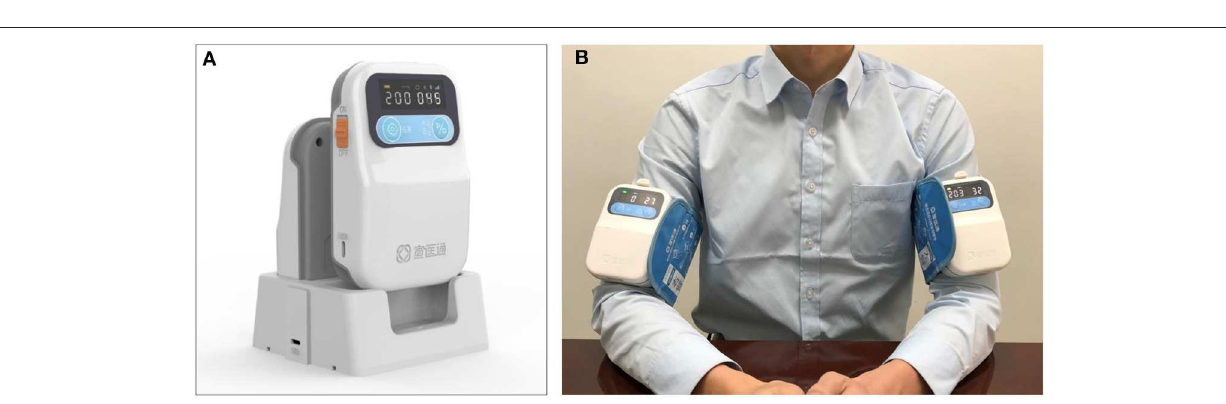
FIGURE 2 | The remote ischemic conditioning device and how it is used. (A) The device used for stimulating remote ischemic conditioning. (B) Remote ischemic condition performed in human, the device can be used on both sides or one side according to the requirements of the